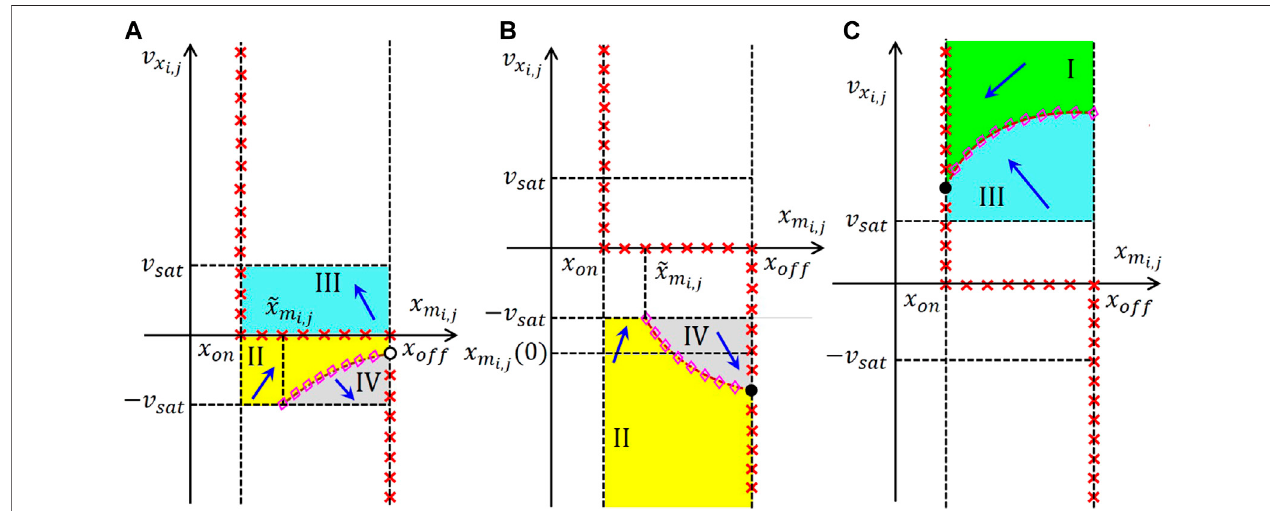
FIGURE20| Qualitativesketchesillustratinggraphicallythestepsofthesystem-theoreticmethodtomassagethecellSDPinthelinear (A) ,negativesaturation (B) , and positive saturation (C) regions for the derivation of a suitable gene to program the M-CNN for the data retrieval